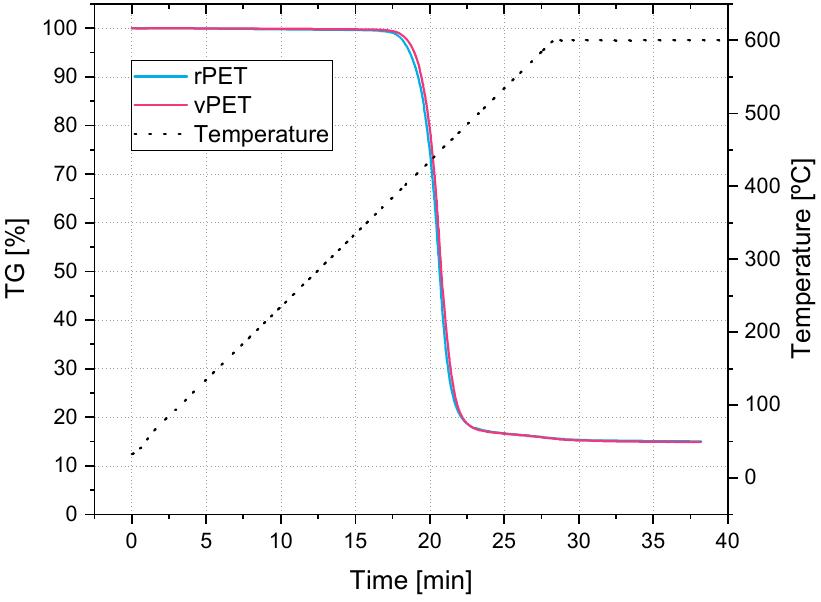
Figure 11. TGA in nitrogen atmosphere for the determination of pyrolytic black carbon content. Figure 12 displays the results of the second heating and cooling cycle of the DSC measurement. The first results were obtained with a heating and cooling rate of 10 K/min. The light blue curves represent the virgin PET and the pink curves represent the recycled PET. Both materials showed a similar behavior. The heating cycle is represented by